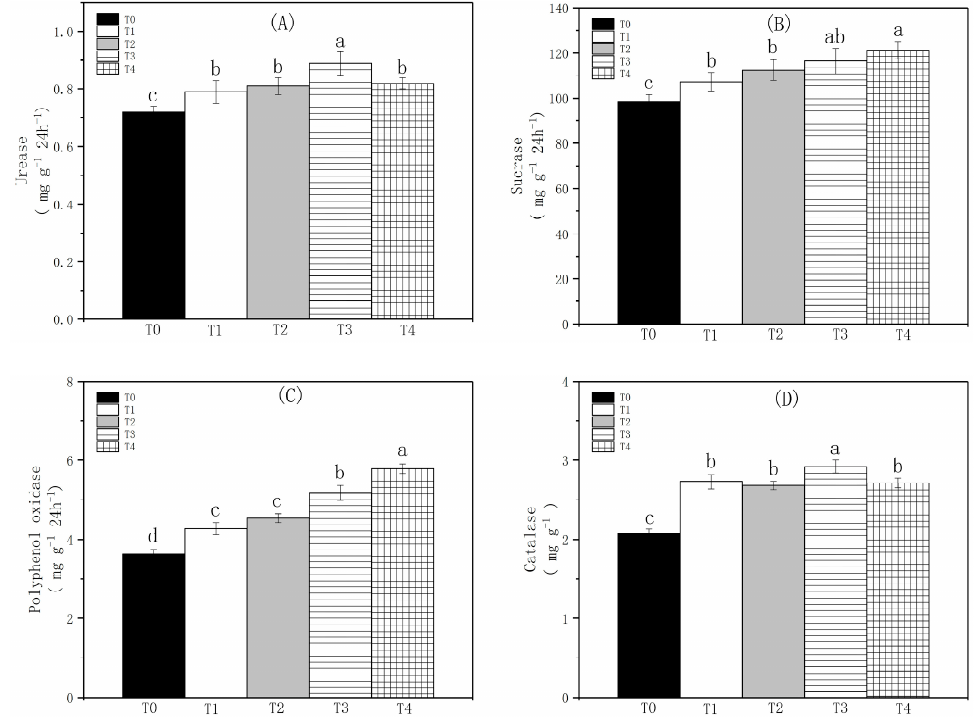
Figure 3. The effect of different amounts of biochar on soil enzyme activity. ( A ) Urease; ( B ) sucrase; ( C ) polyphenol oxidase; ( D ) catalase. Different lowercase letters indicate significant differences between treatments ( p < 0.05). Table 4. The impact of biochar on soil microbial biomass carbon (MBC), microbial biomass nitrogen (MBN), total organic carbon (TOC), and total nitrogen (TN). Different letters in the same column indicate significant differences between treatments ( p <